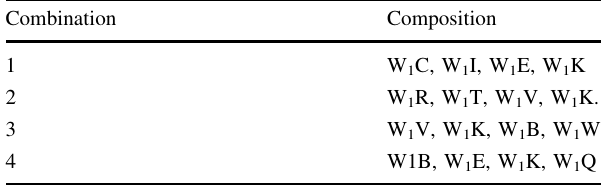
Table 4 Proposed composition of the